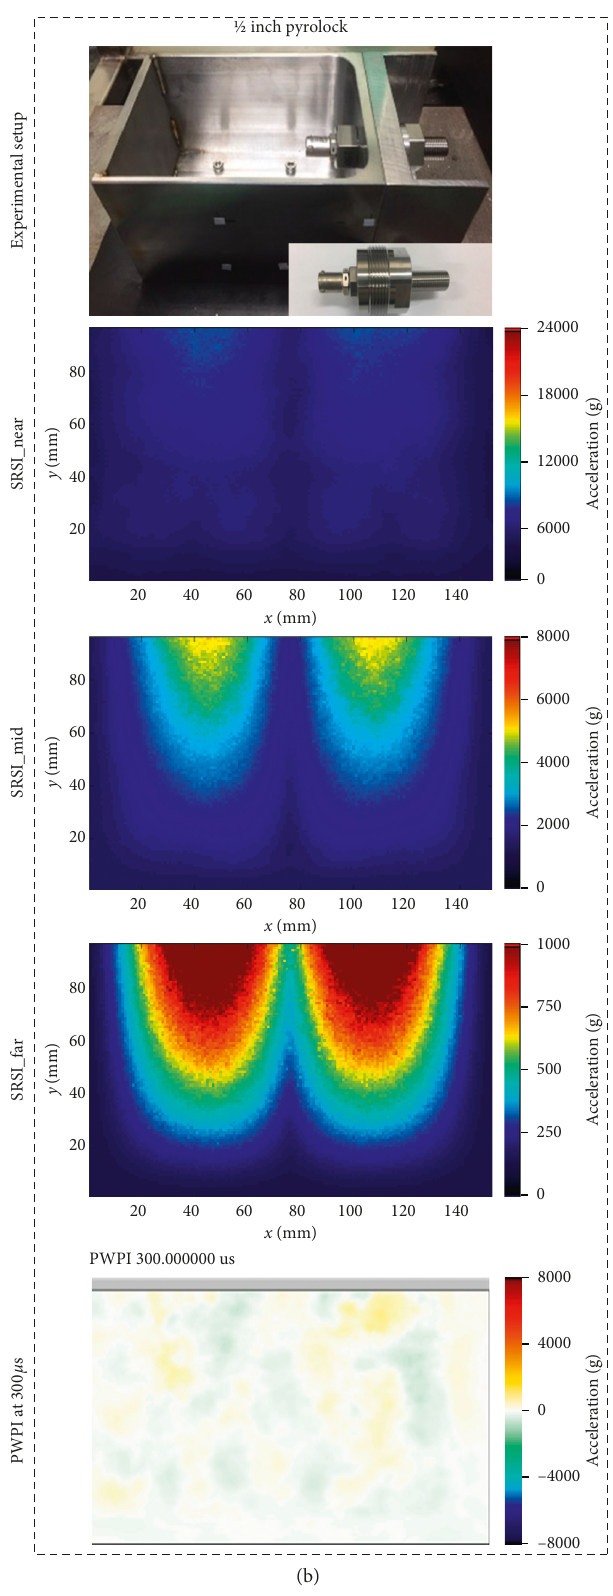
Figure 13: Evaluation of the pyroshock propagation in temporal and spectral domains on the open-box-type specimen: (a) simulation results of 1/2 inch explosive bolt-induced pyroshock (b) simulation results of 1/2 inch pyrolock-induced